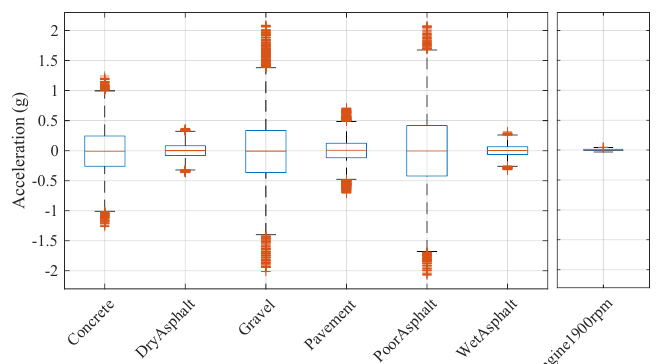
Figure 4. Signal-magnitude comparison for each surface. Case is represented in which the vehicle was at a standstill and the engine was revving at 1900 rpm (Engine1900